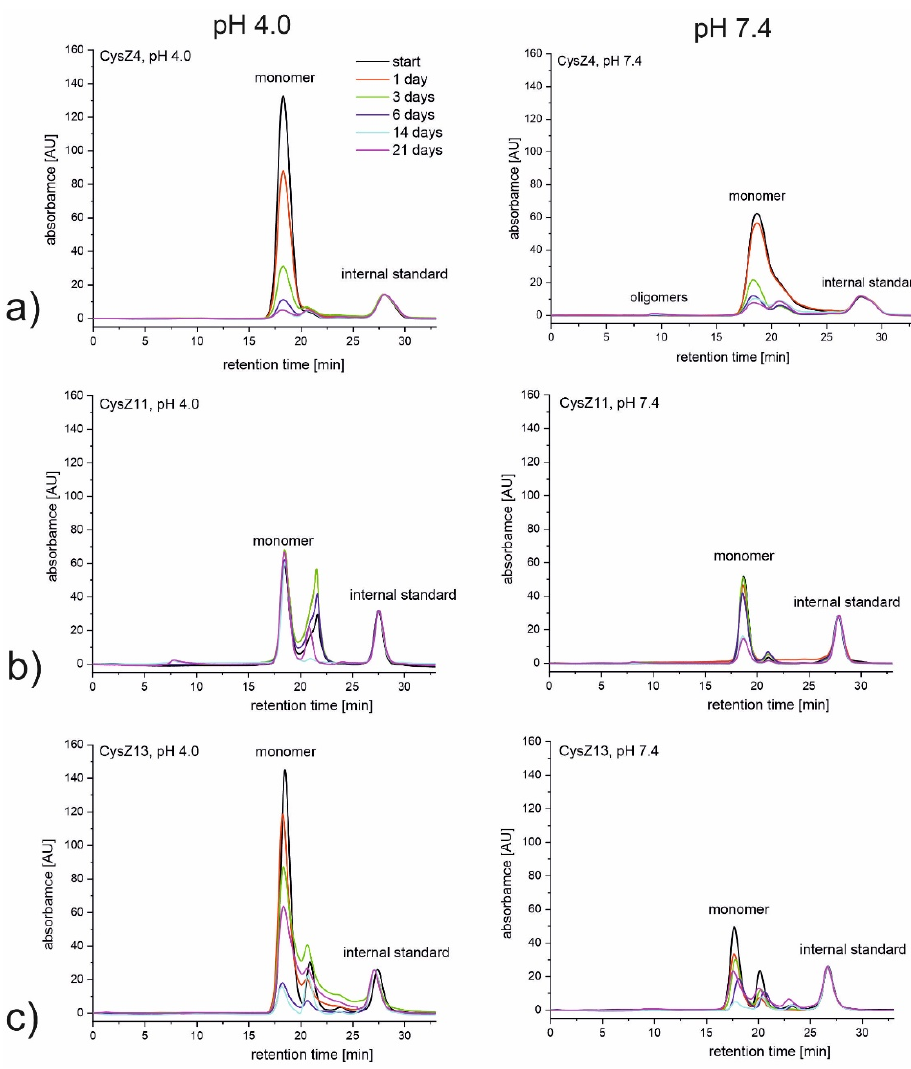
Figure 2. SEC chromatograms recorded during 21 days of incubation at 37 °C in PBS pH 4.0 (left side) and pH 7.4 (right side) for peptides ( a ) CysZ4; ( b ) CysZ11; and ( c ) CysZ13.